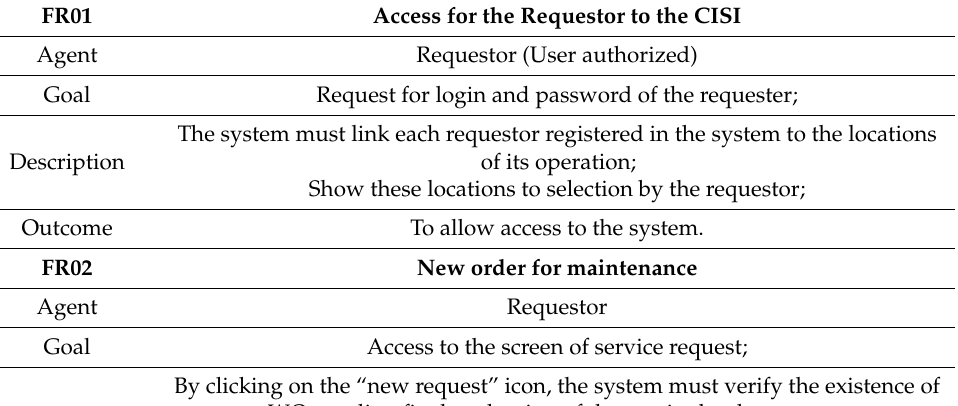
Table 3. Specification of functional requirements for the redesign of the information technology system used in the issuance of WOs for the maintenance of HVAC